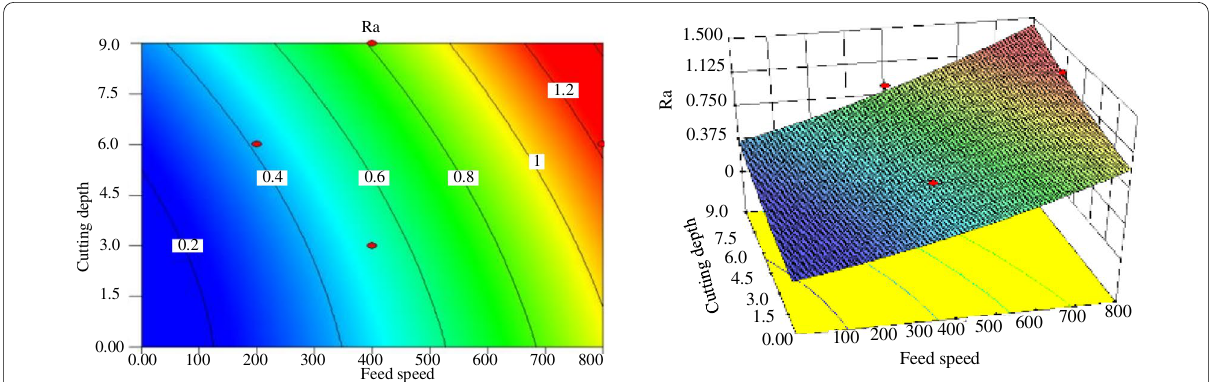
Figure 12 3D response surface figure of surface roughness regression equation [response surface and contour of (B) and (C)]